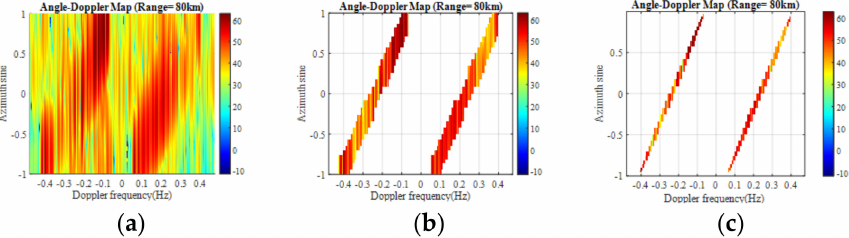
Figure 5. The description of the clutter ridge. ( a ) Angle-Doppler map, the dashed-line represents the theoretical clutter ridge. ( b ) The extracted clutter ridge when all beam channels within 3 dB less than the maximum value are selected for a determined Doppler frequency. ( c ) The extracted clutter ridge when three beam channels are selected for a determined Doppler